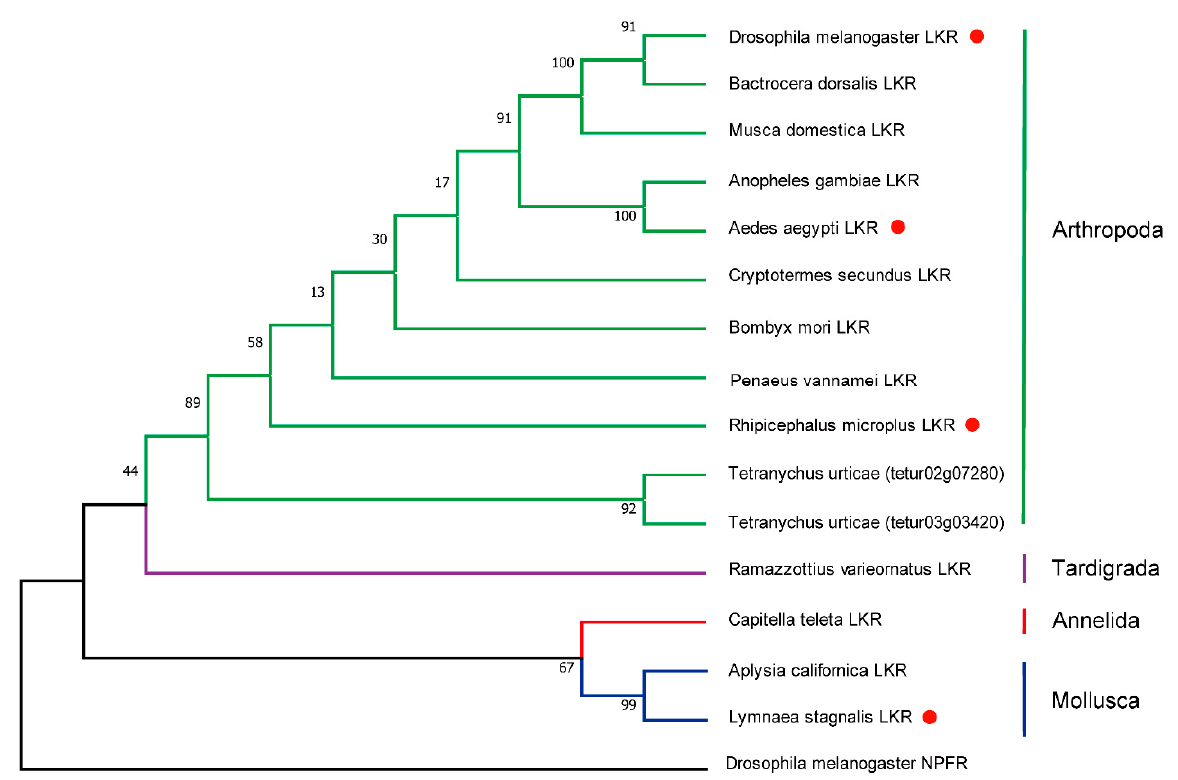
Figure 4. Phylogeny of leucokinin receptors. Drosophila neuropeptide F receptor was used as out-group to root the tree. Amino acid sequences of full-length receptors were used for the analysis. Sequences were aligned using the Clustal X. Maximum likelihood trees were constructed by MEGA X software. The numbers at the nodes of the branches represent the percentage bootstrap support (1000 replications) for each branch. Receptors that have been functionally characterized are indicated by a red symbol after the species name. Sequences used to generate the phylogeny are provided in Supplementary Material Text File S1.